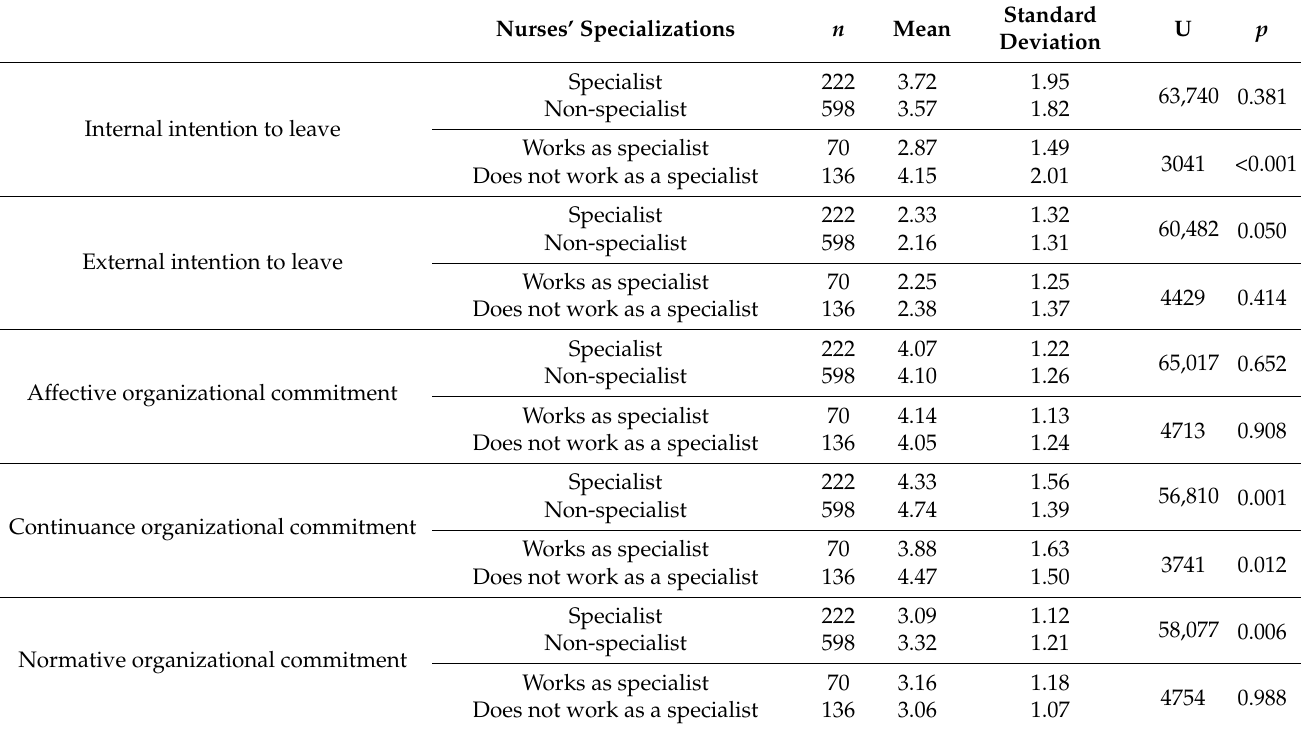
Table 4. Results of the Mann–Whitney test on the intention to leave and organizational commitment, according to nurses’